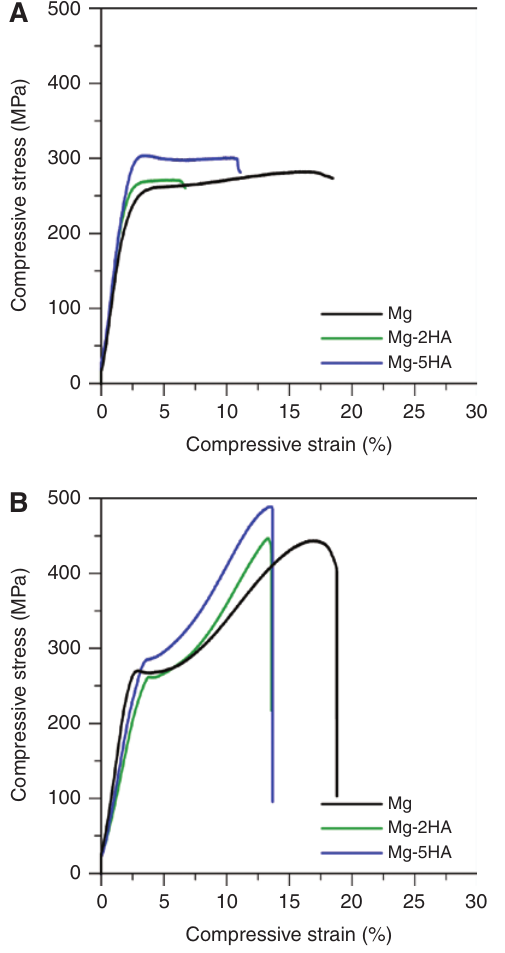
Figure 9: Compressive tests of studied materials: (A) The effect of extrusion temperature on the compressive behavior of pure Mg and Mg-5Ha prepared by mixing of powders in planetary mill and subsequent extrusion at 300 ° C, 400 ° C, and 500 ° C. (B) Compressive behavior of Mg-5HA prepared by self-sustained high-temperature synthesis (SHS) in comparison with extruded